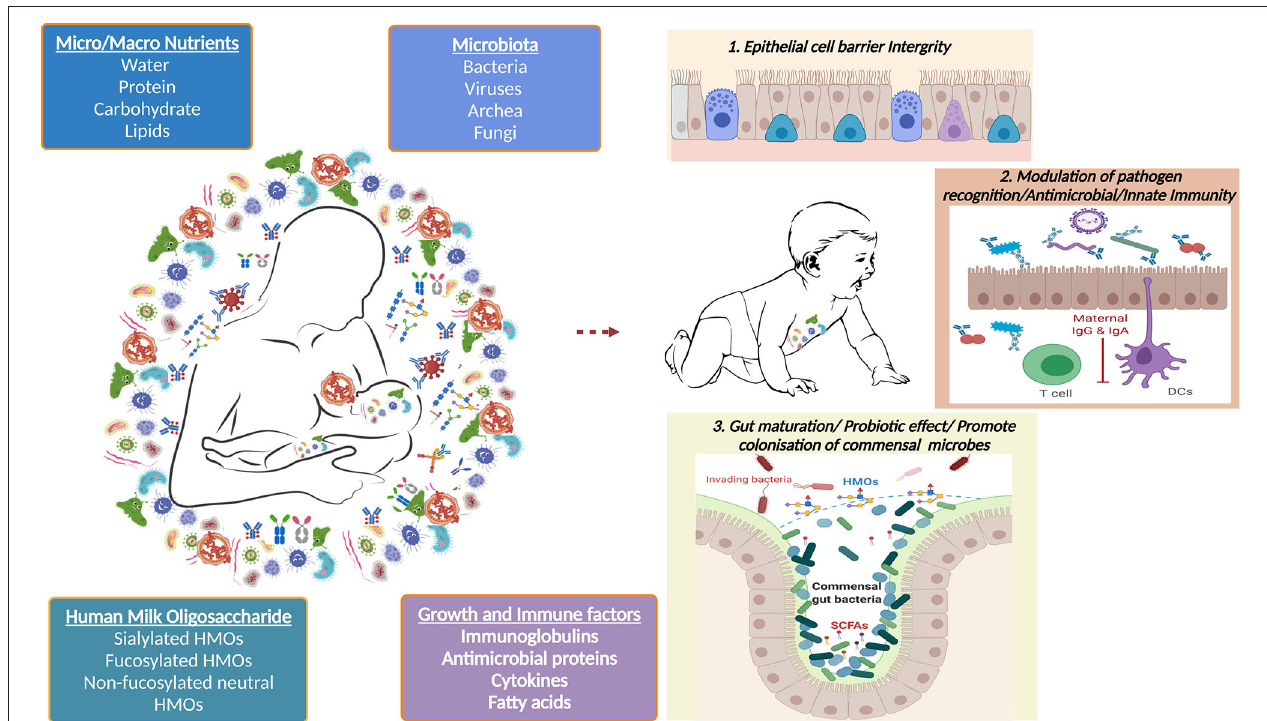
FIGURE 5 | Overview of the human breast milk composition and its impact on infant’s